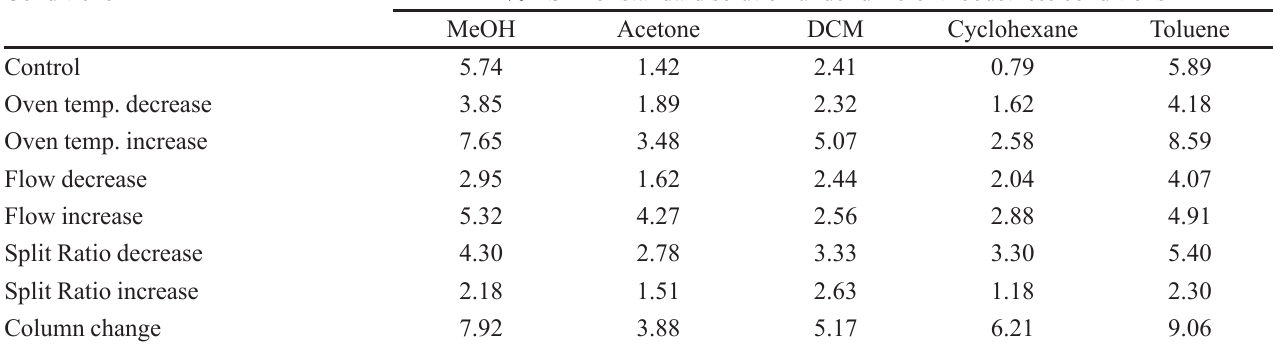
Intermediate Precision